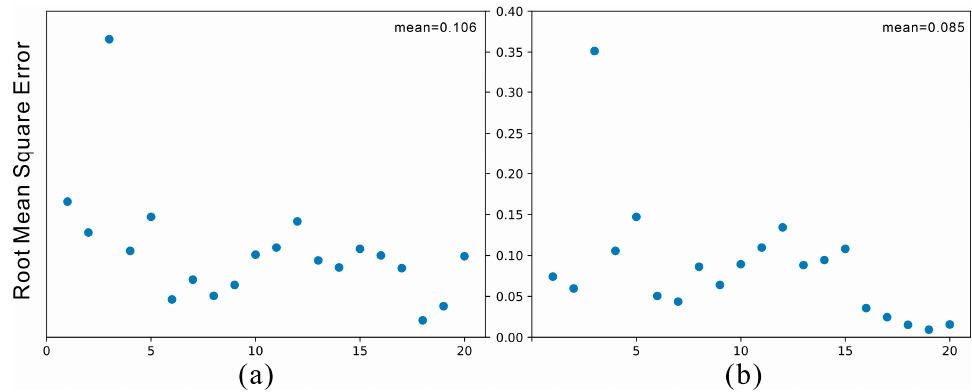
Figure 6. RMSE of each interpolation result with different methods: ( a ) RMSE of the results interpo- lated by OK. The mean RMSE is 0.106; and ( b ) RMSE of the results interpolated by UK. The mean RMSE is 0.085.